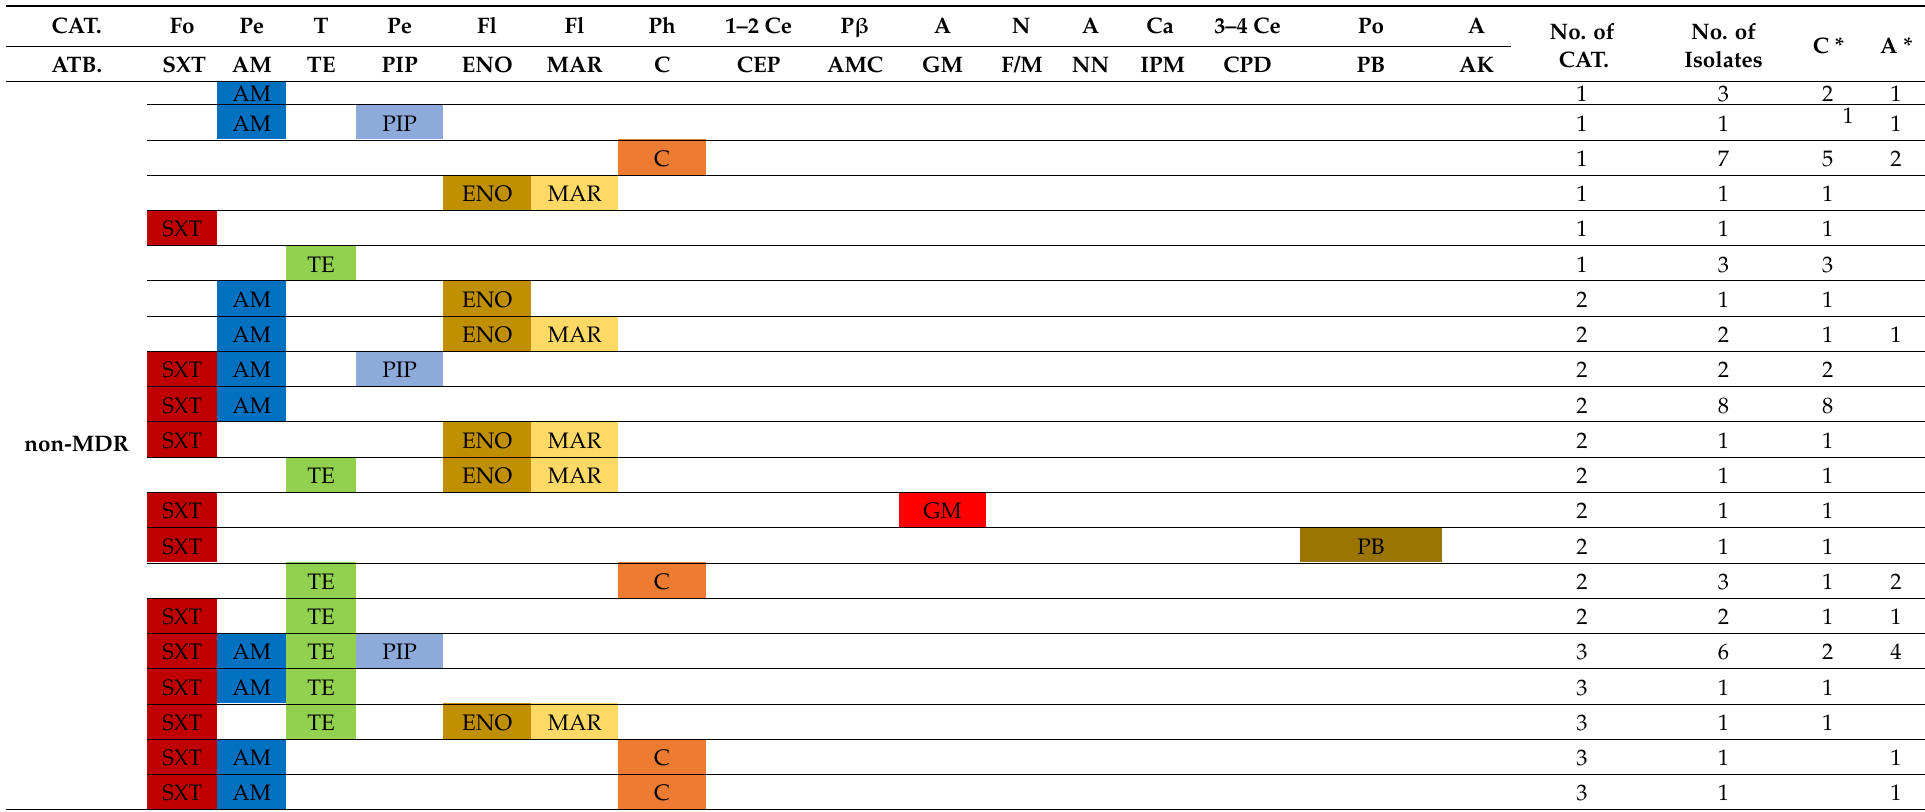
Table 2. Antimicrobial resistance phenotypes. The antimicrobials have been ordered by their frequency in the isolates and the number of antimicrobial categories. The number of isolates in each group of age is also included.